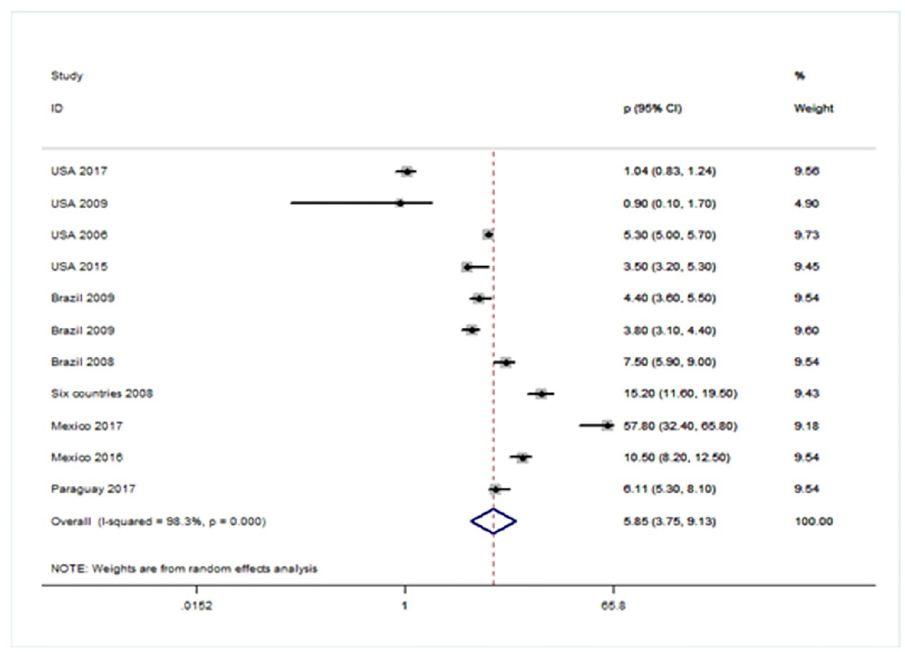
Fig 6. Forest plot showing prevalence of URE among children aged < 20 years in American